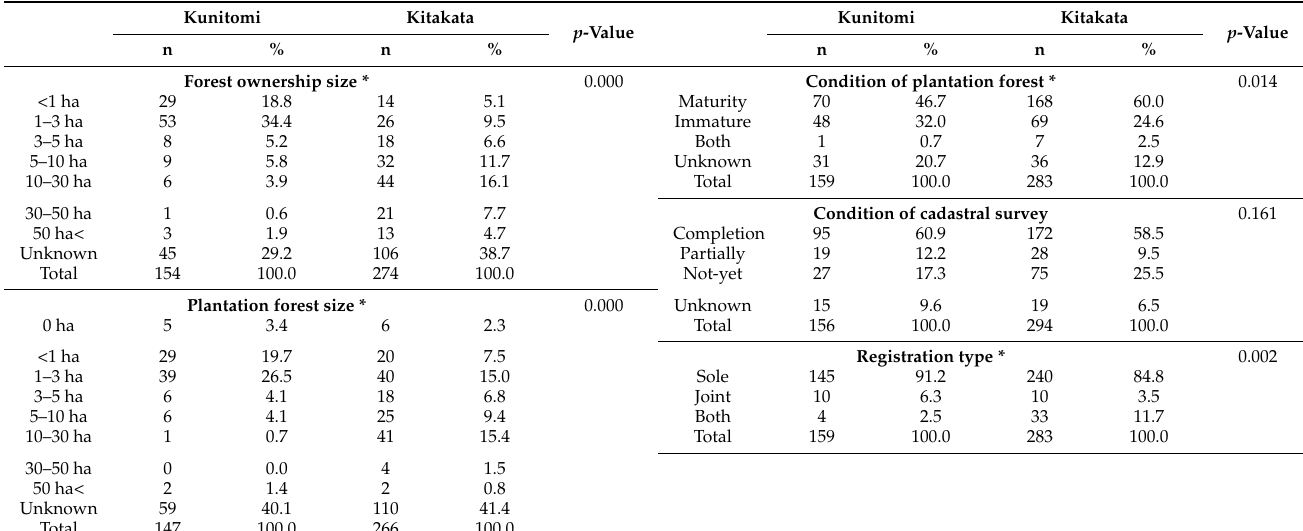
Table 2. Comparison of forest conditions between the two